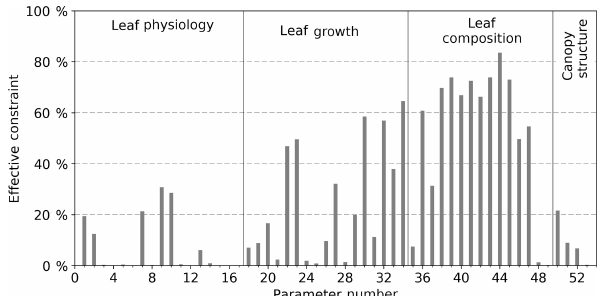
Figure 1. Effective constraint of BETHY-SCOPE model process parameters from SIF observations. Only the parameter numbers are given; for the corresponding descriptions, see Table